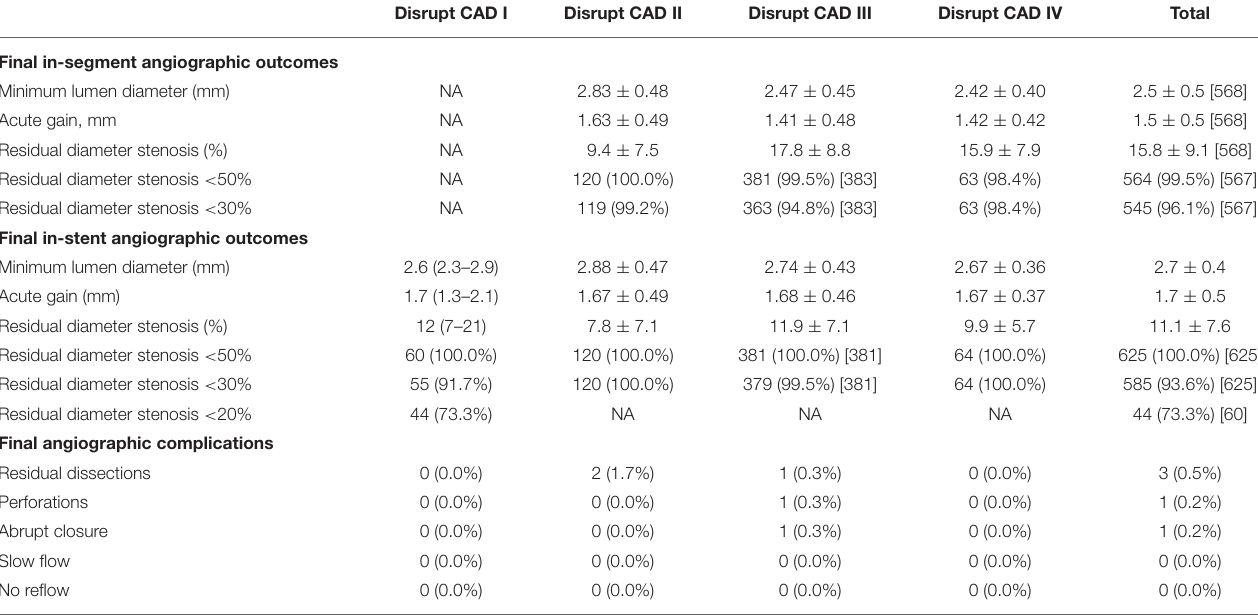
TABLE 6 | Angiographic outcomes.